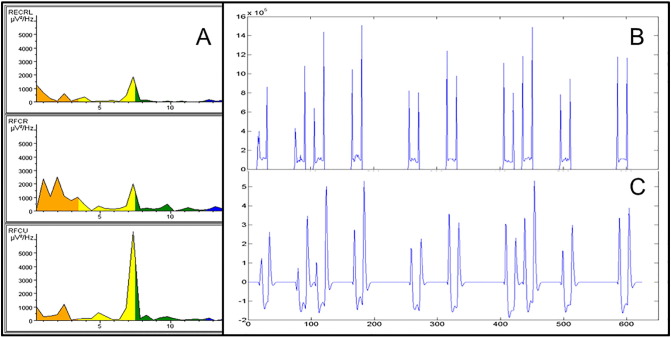
Representative EMG characteristics for one patient. A: Fast Fourier Transform during task of 3 right arm muscles (from top to bottom: ECRL, FCR, FCU). B: EMG regressor: mean EMG per scan of the 3 right arm muscles in A across the task. Higher values are associated with hand and arm extension. C: rEMG regressor as used in the fMRI model: EMG regressor in B after orthogonalization, convolving with the hrf and scaling by its SD.